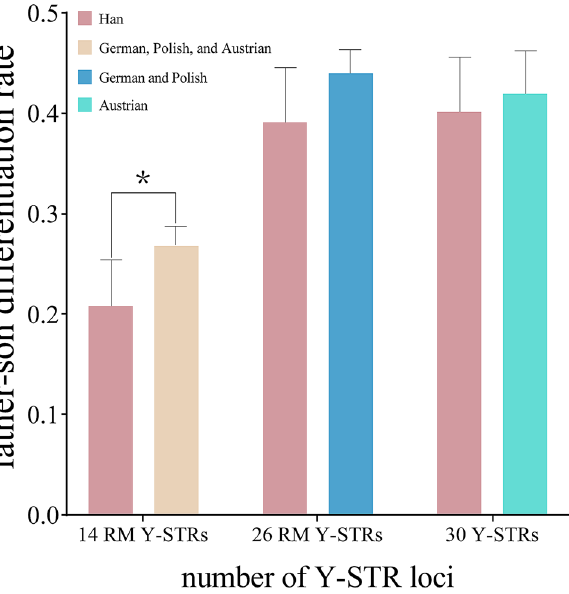
Figure 3. Father-son differentiation rates under different numbers of RM Y-STR loci in Chinese and European populations. Error bars represented 95%